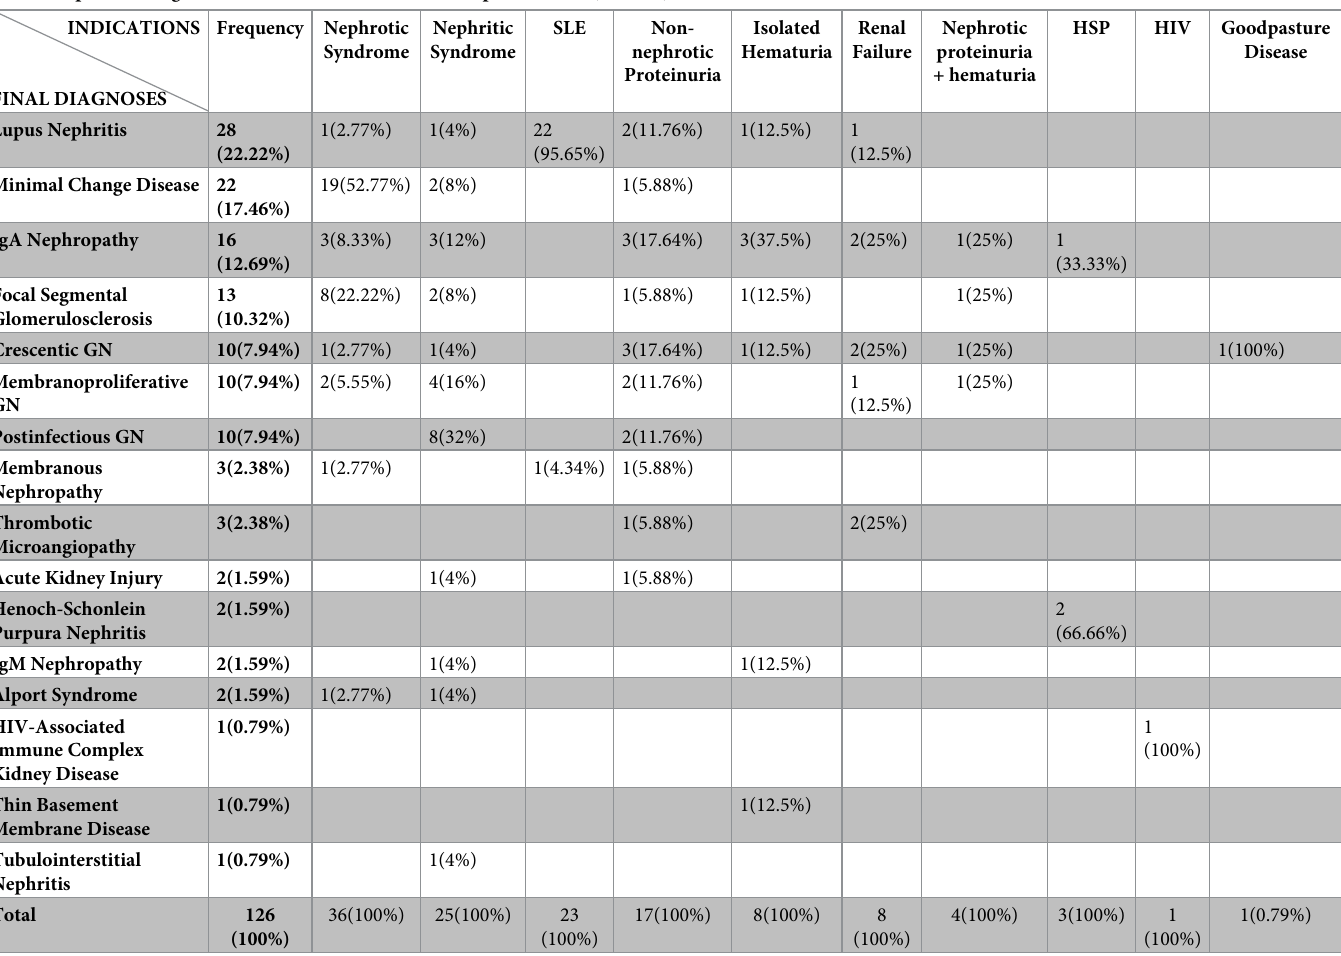
Table 3. Spectrum of glomerular diseases and their clinical presentation (N =